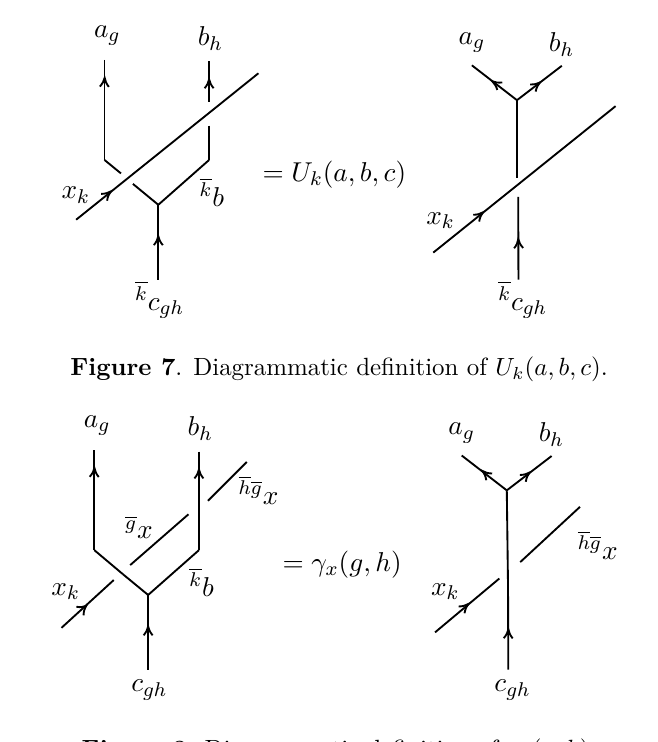
Figure 8 . Diagrammatic definition of γ k ( g, h )